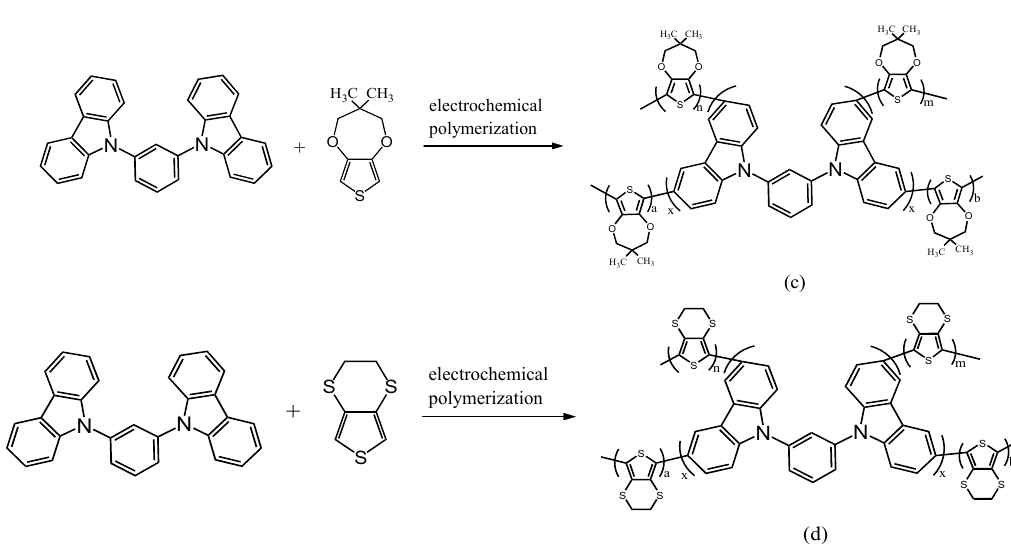
Figure 4. The electrochemical polymerization routes of: ( a ) PBCz; ( b ) P(BCz- co -EDOT); ( c ) P(BCz- co -ProDOT); and ( d ) P(BCz- co -EDTT).